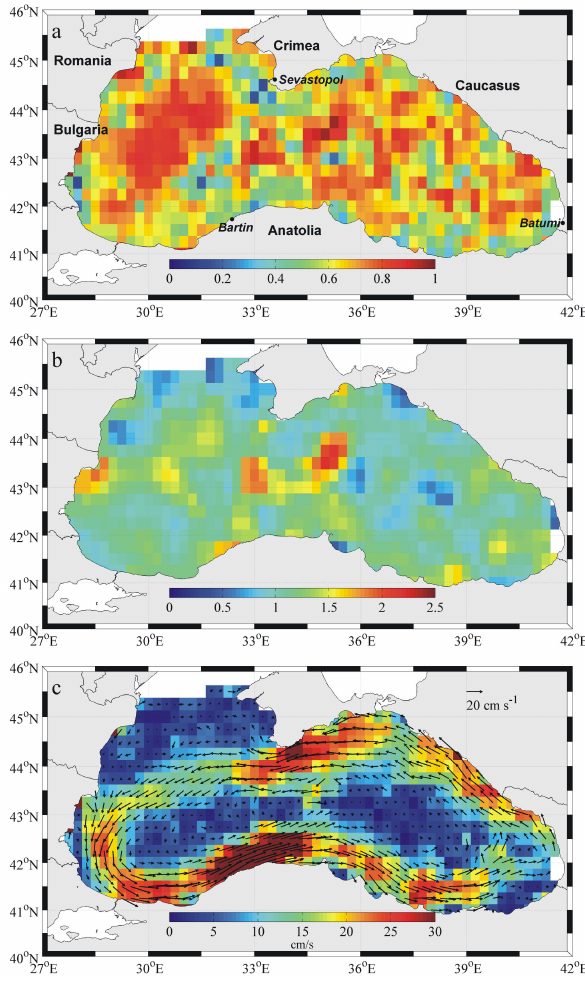
Fig. 1. Spatial distribution of the magnitude of (a) the complex correlation between drifter geostrophic velocities U DG and satel- lite anomalies of surface geostrophic velocities U SLA ; (b) the low pass filtered slope | A | and (c) the offset B depicted with vectors and